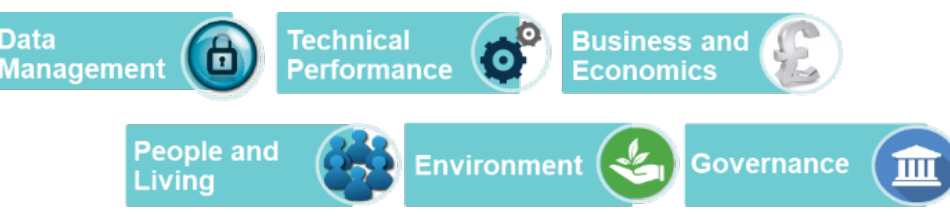
Figure 2. Six themes for classifying benefits and performance of